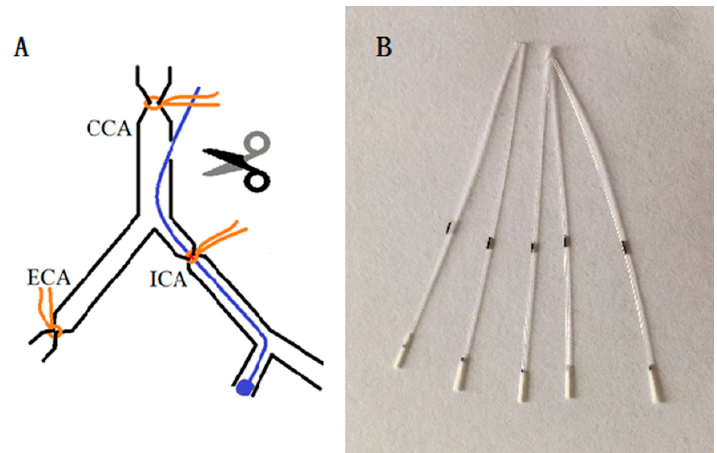
Figure 10. ( A ) The modelling method of pMCAO. CCA: common carotid artery; ECA: external carotid artery; ICA: internal carotid artery; Black lines represent the blood vessels, yellow lines represent the sutures, and the blue line represents the filament; ( B ) The filament used in this study. The length of the filament is 45 mm, the diameter of nylon wire is 0.28 mm, and the diameter of head end (wrapped with silastic) is 0.38 ± 0.02 mm. The mark is 20 mm to the head end.